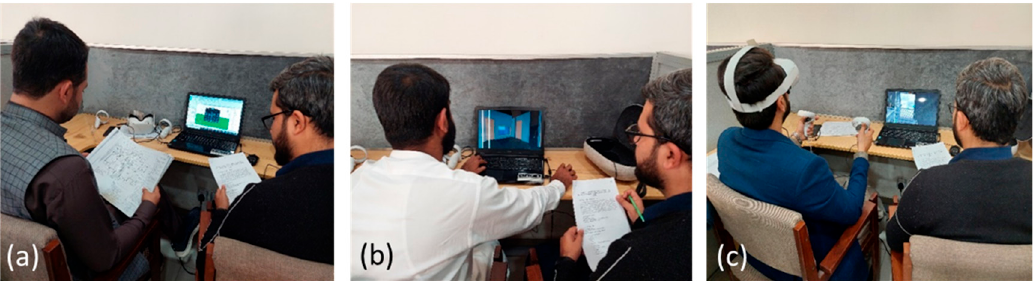
Figure 4. Participants performing design review tasks in ( a ) paper-based drawing, ( b ) monitor-based drawing, and ( c ) Oculus Quest 2-based drawing.